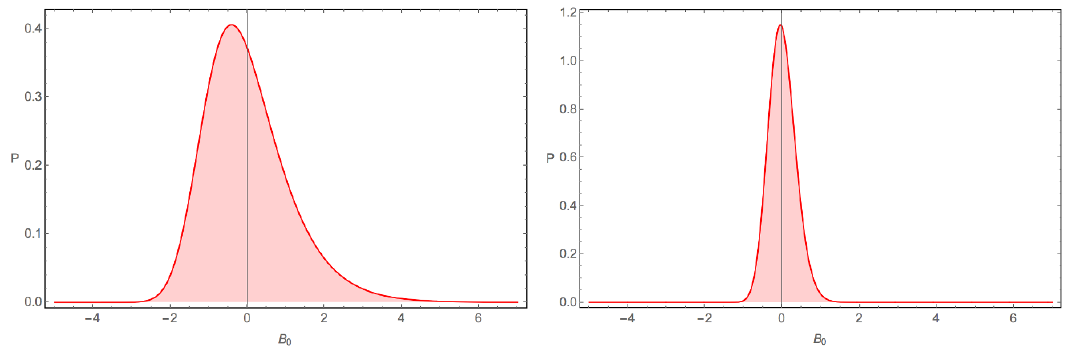
Figure 5 . Probability distribution P ( B 0 ) for N = 2 (left) and N = 20 (right). (For comparison to (cid:12)gure 4, recall that B 0 = (cid:25) 2 b 0 (cid:25) 2 : 5 b 0 4